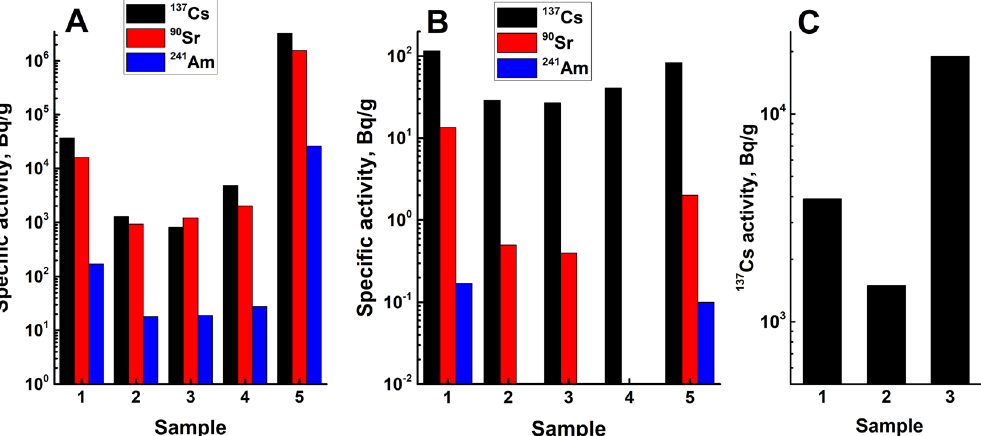
Fig. 2 Distribution of some fuel-related radionuclides in cross-section of the graphite block as studied after the reactor shutdown. A Graphite block directly affected by the LOF accident. B Block distant from the accident spot. C Graphite sleeve irradiated only in the three fi nal years of the reactor operation, total sleeve thickness — 20 mm. No actinides are detected in the sleeve. In A , B , point 1 is at the contact between the internal borehole in the graphite block and the sleeve, point 5 — outer surface of the block. In C , point 1 is at the contact with technological channel, point 3 — outer edge of the sleeve (contact with graphite